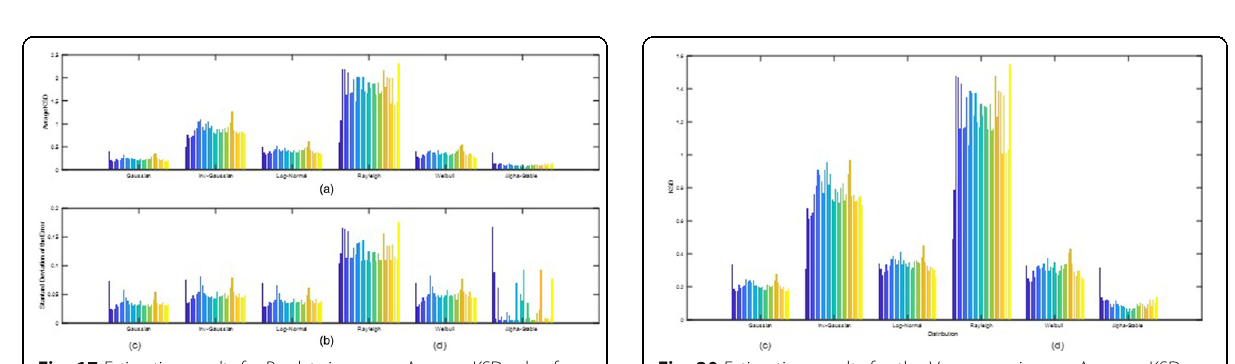
Fig. 20 Estimation results for the Vancouver image. Average KSD values for different distributions in each subband